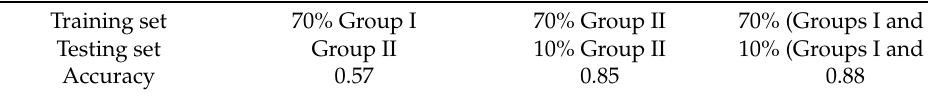
Table 9. Accuracy results of Group